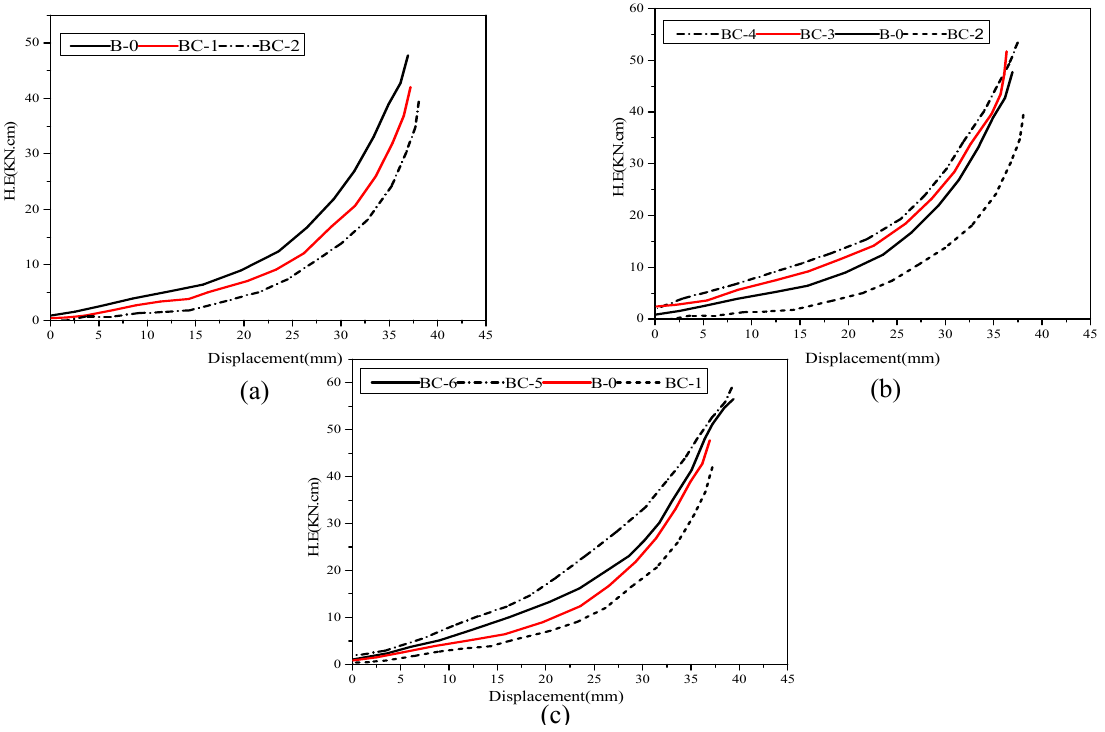
Figure 11. Energy Dissipation for tested specimens: ( a ) for unstrengthened beams, ( b ) for strengthened opening beams in the shear zone, ( c ) strengthened opening beams in the flexural zone.